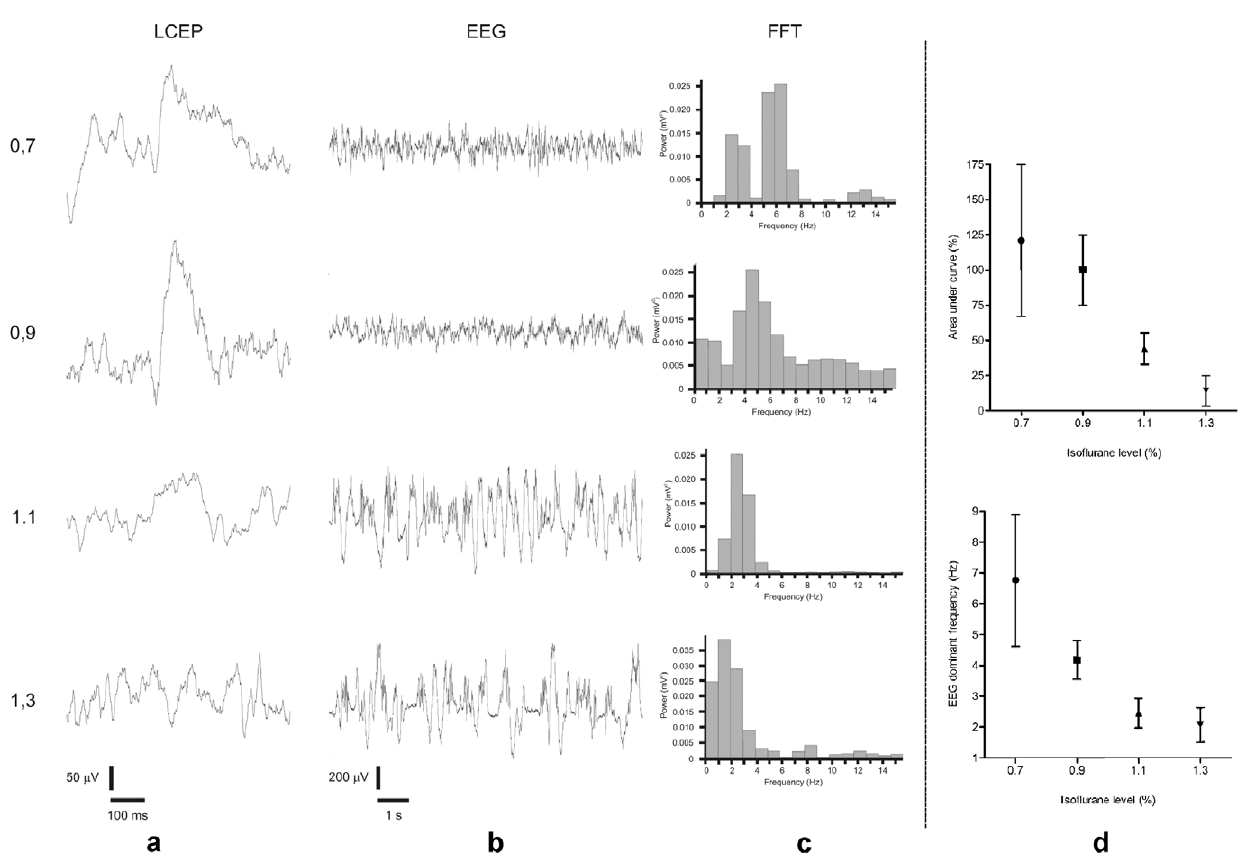
Figure 1. The effect of different Isoflurane concentrations ( % ) on LCEP ( a ) and EEG ( b ) . Frequency distribution (FFT=fast Fourier transformation) of sampled EEG (c). (a–c) show averaged LCEP, raw data EEG sweeps and FFT from a single animal. (d) Normalized grand mean and standard deviation of averaged LCEP area under curve (AUC) and EEG dominant frequency recordings from five rats. 100% corresponds to the mean LCEP AUC at 0.9% isoflurane.